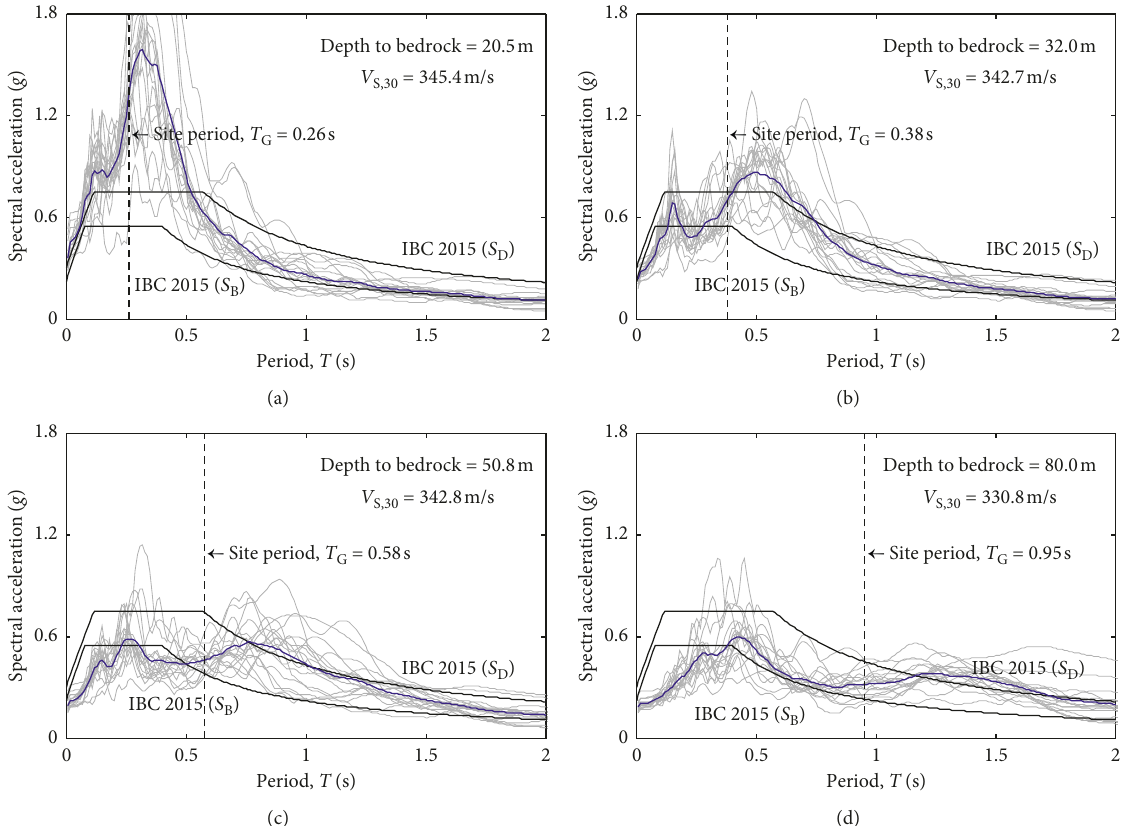
Figure 10: Response spectrum resulting from numerical analysis of four S